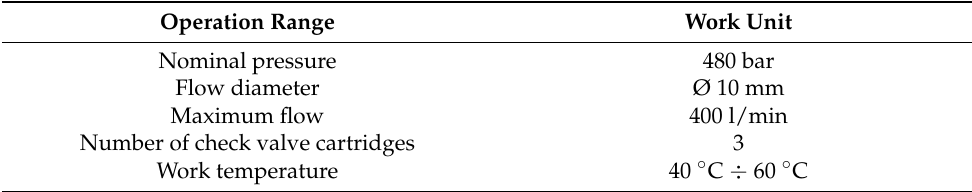
Table 2. Technical characteristics of the prototype double